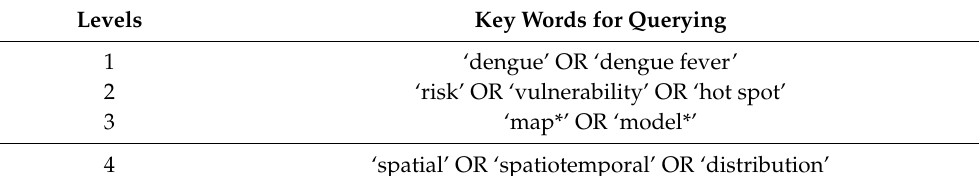
Table 1. Keywords for the set of four-level querying. Levels Key Words for Querying